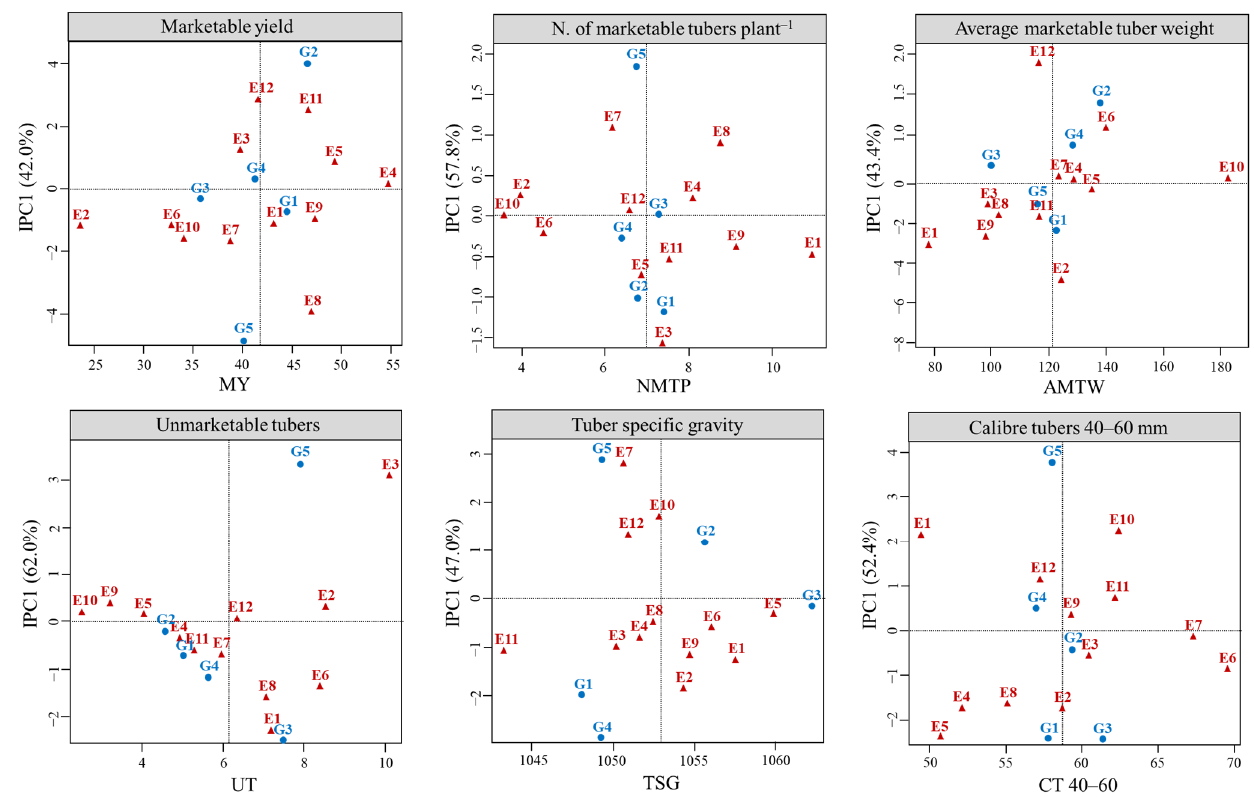
Figure 2. ‘AMMI 1’ biplot showing the mean trait effect and the first interaction principal compo ‐ nent (IPC1) of five potato genotypes (G) over 12 environments (E). The biplots were constructed with scaling = 0, centering = 2, and SVP = 2. G1: Arizona; G2: Generosa; G3: Levante; G4: Paradiso; G5: Vogue; E1–E4: Acireale (seasons I to IV); E5–E8: Giarre (seasons I to IV); E9–E12: Mascali (seasons I to IV).